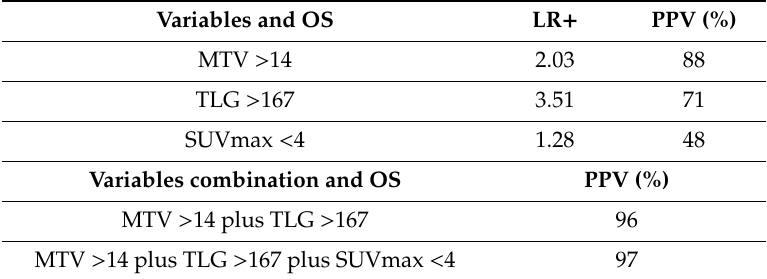
Table 5. Predictors of Overall Survival (OS). The variables analyzed were the maximum standardized uptake value (SUVmax), the metabolic tumour volume (MTV), the total lesion glycolysis (TLG) of the primary tumours. LR + , likelihood-ratio positive; PPV, Positive Predictive